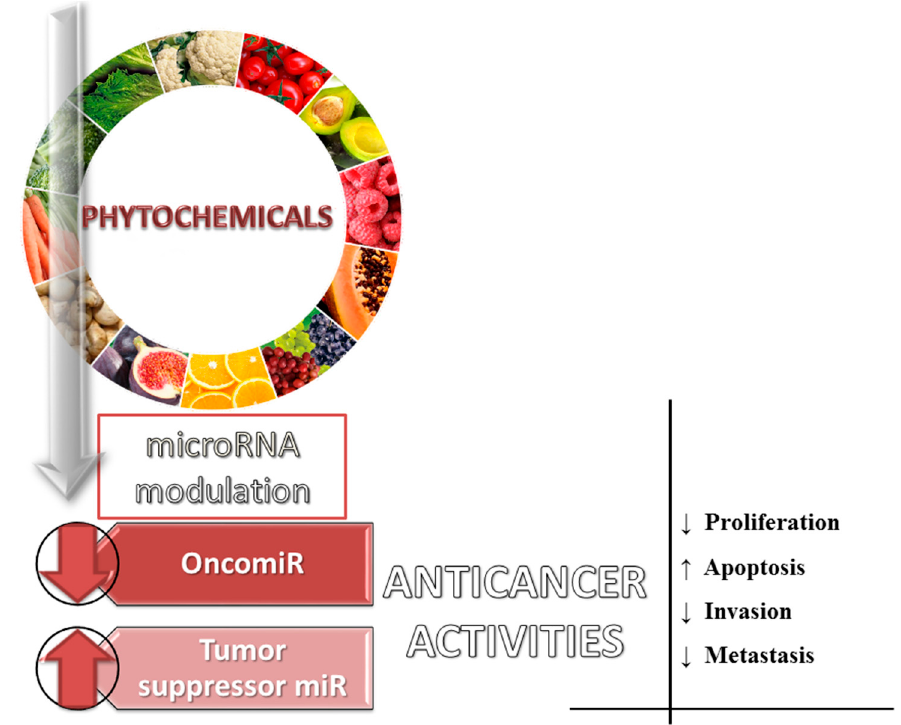
Figure 3. Involvement of dietary phytochemicals in the modulation of oncogenic/tumour suppressor miRNAs, interfering with key cellular and molecular processes ( ↑ : upregulated miRNA; ↓ : downregulated miRNAs).